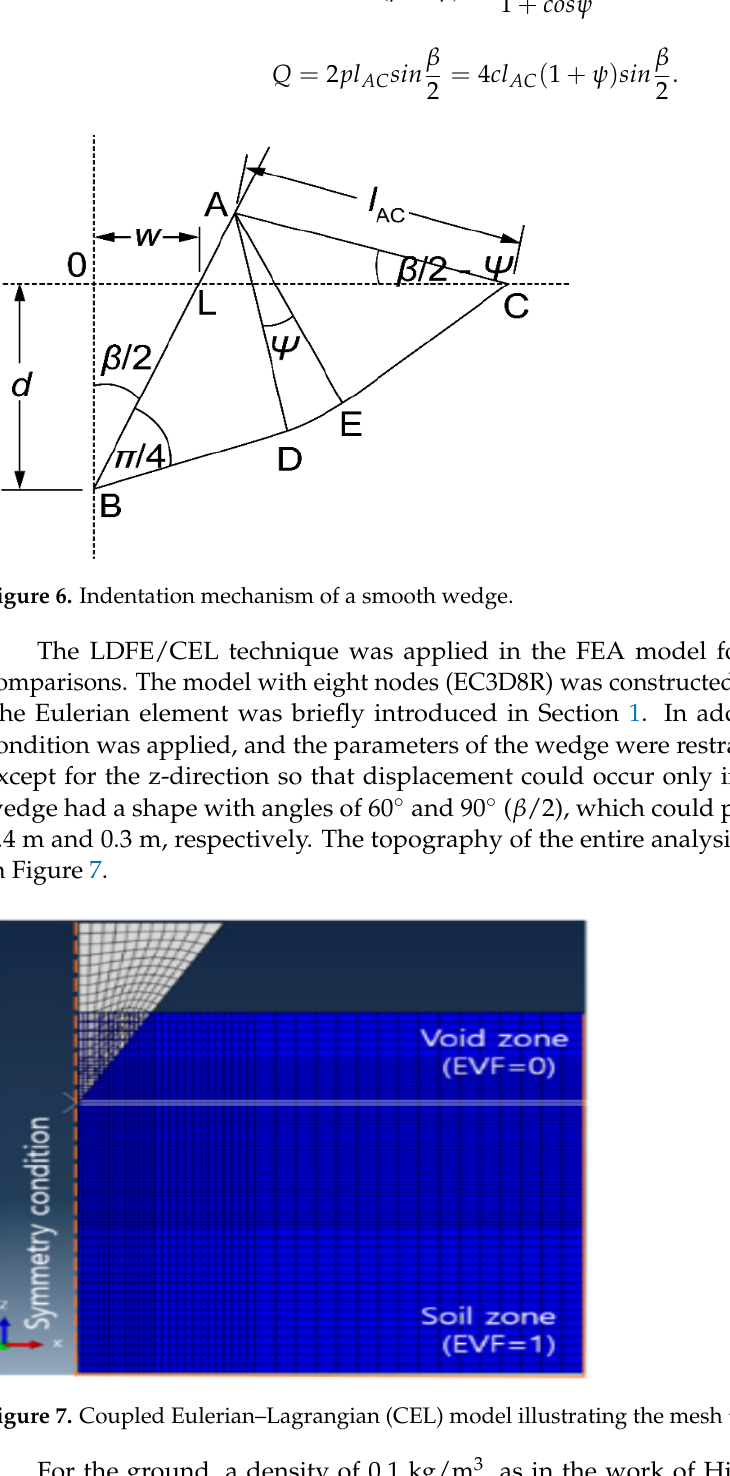
Figure 8. Influence of 𝛽 on wedge indentation in CEL analysis [25].